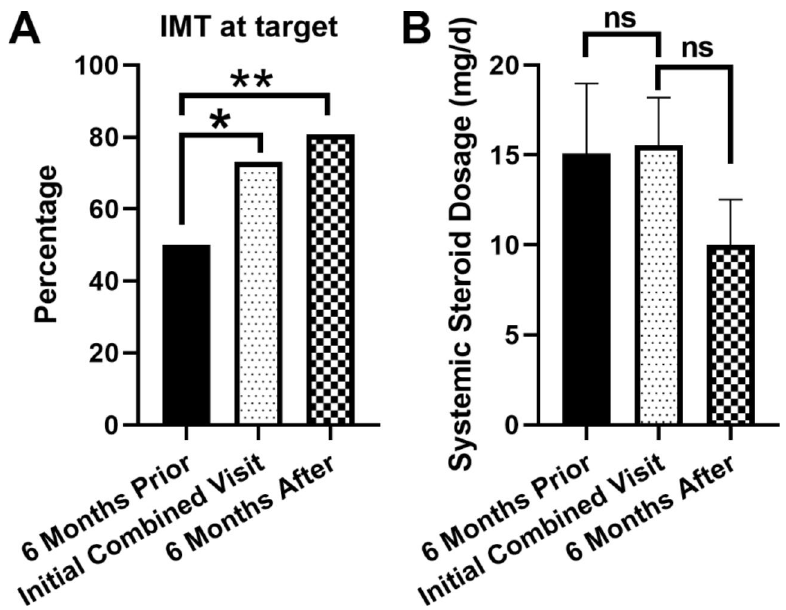
Fig. 2 Comparison of the frequency and dosage of systemic immunosuppressive therapies used in patients between the initial combined visit and 6 months prior to and after the initial combined visits. (A) The frequency of patients at target dosage of systemic immunomodulatory therapy (IMT). Fisher’s exact test. * p <0.05. ** p <0.01. (B) The average of daily systemic corticosteroid dosage at the three visits. Paired Student’s T test. ns: not